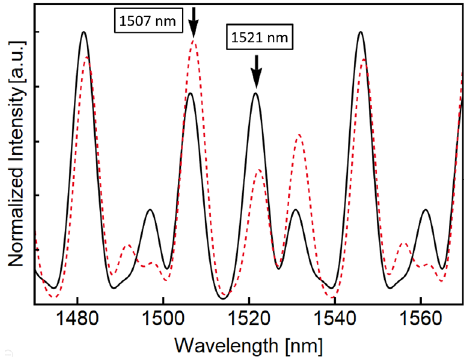
Figure 2. Simulated transmitted spectral response of two SMF ‐ SCF ‐ SMF devices of 10 and 6 cm. The black solid curve corresponds to the response at room temperature using Equation (2). The red dotted curve corresponds to the same devices when the temperature in the SMF ‐ SCF ‐ SMF device of 6cm is increased by 100 °C. The black arrows indicate the ratiometric behavior. The intensity increases with temperature for some peaks, while the opposite behavior is observed for other peaks.